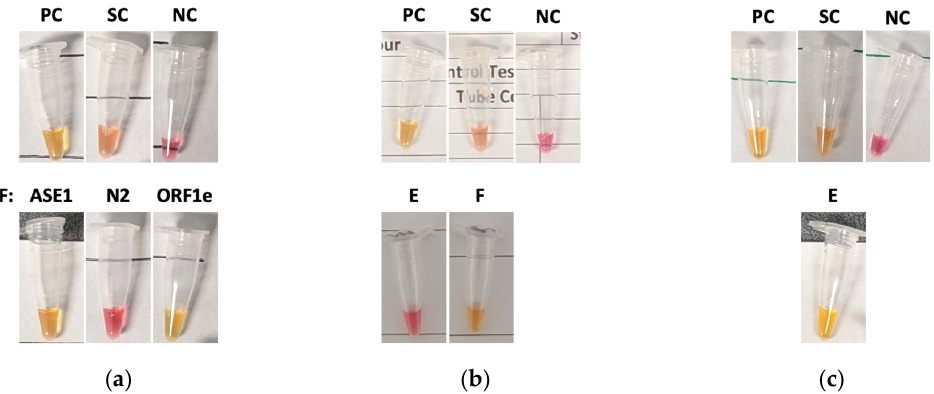
Figure 3. Original RT-LAMP test results from individuals E and F. ( a ) Tuesday, 3 November: individual F’s saliva sample was processed and subjected to RT-LAMP using AS1E, N2, and ORF1e primer sets against SARS-CoV-2. ( b ) Wednesday, 4 November: individual E and F’s saliva were tested using AS1E per a regular scheduled testing day. ( c ) Thursday, 5 November: individual E’s saliva sample was deemed positive with the AS1E primer set against SARS-CoV-2. PC—SARS-CoV-2 virus control; SC—saliva control (RNase P); NC—negative control; AS1E, N2 and ORF1e—primer sets targeting SARS-CoV-2 genes. A negative amplification of the gene target resulted in the solution remaining pink (basic pH), whereas target gene amplification resulted in a color change from pink to yellow (acidic pH).